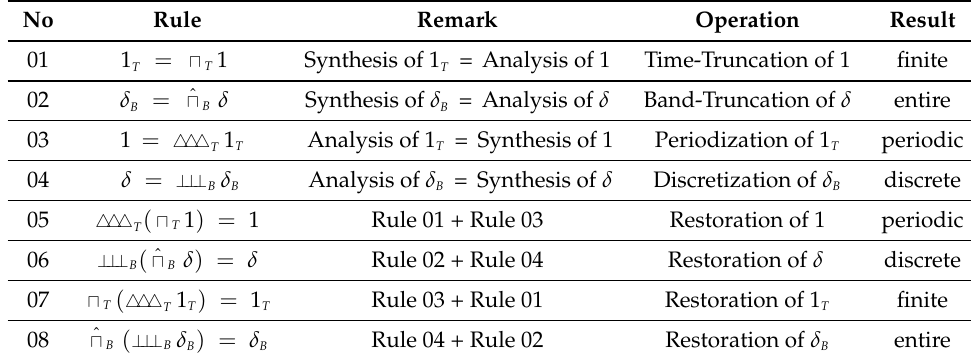
Table A1. Unitary Functions—Synthesis & Analysis.